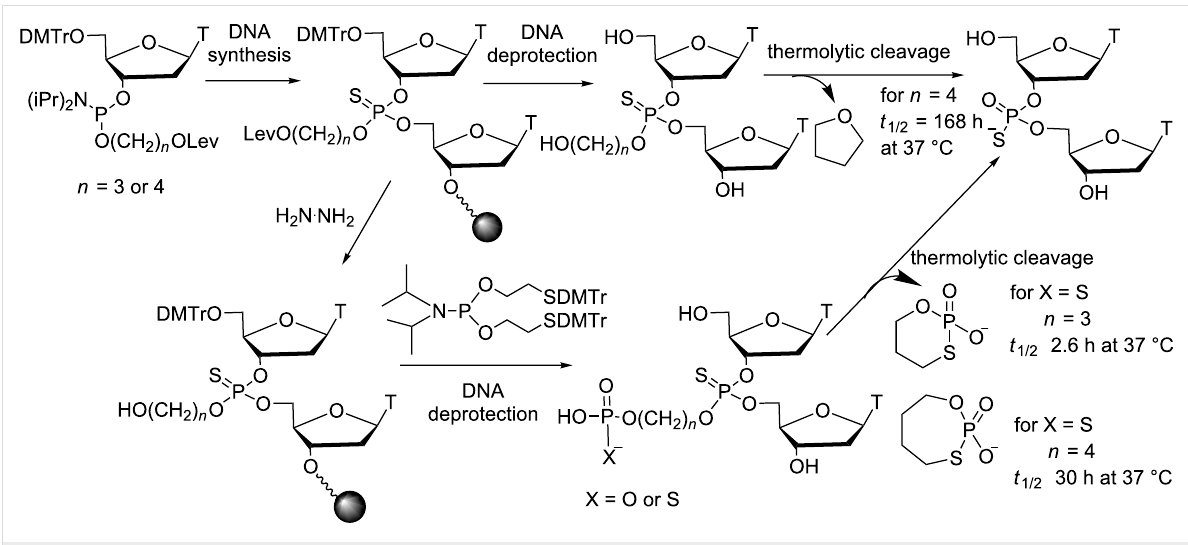
Scheme 14: Thermolytic cleavage of the hydroxy-alkylated thiophosphate and phosphato-/thiophosphato-alkylated thiophosphate protecting groups from thymidine dinucleotides